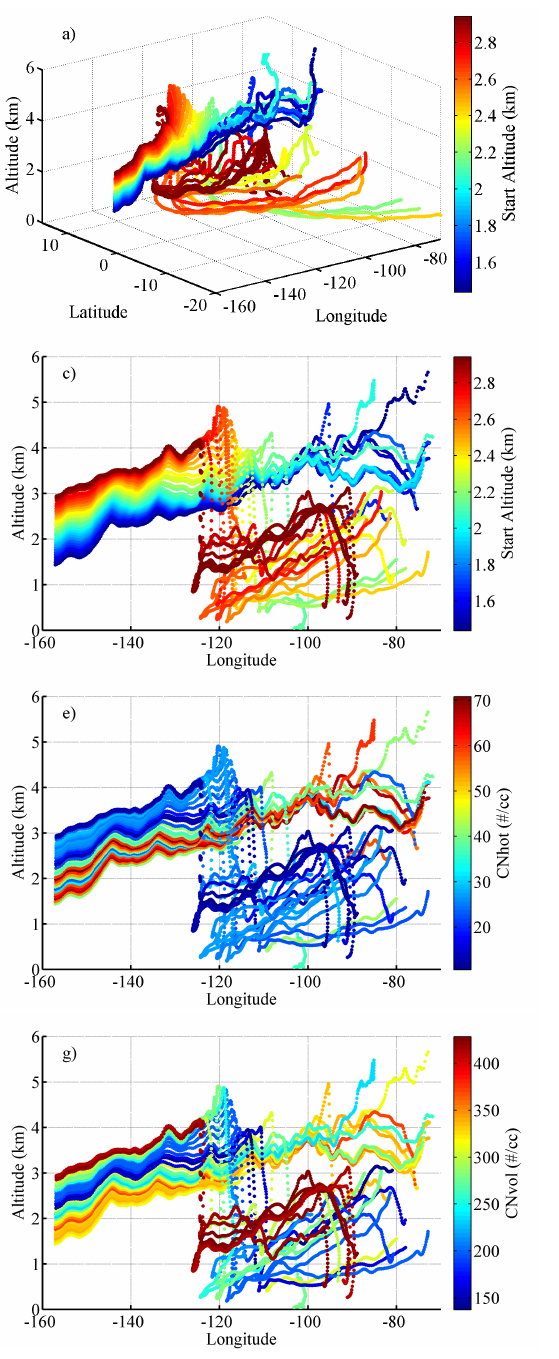
Fig. 6: Case Study I around 19:00 UTC during research flight 2 on 10 August. The 12-day back trajectories are color-coded Fig. 6. Case study I around 19:00UTC during research flight 2 on 10 August. The 12 day back trajectories are color-coded with (a – c) start with (a-c) Start Altitude, (d) total modeled precipitation along the path, (e) CNhot, (f) CO, (g) CNvol and (h) O 3 . altitude, (d) total modeled precipitation along the path, (e) CNhot, (f) CO, (g) CNvol and (h) O 3 . Ecuador and Columbia where rising motion is evident. As (Fig. 6c) from this altitude into the study region. Hence, provides another view of these trajectories over longitude accumulated over the length of 12 days for each trajectory, the modeled air parcels travel west they gradually subside measured pollution aerosol could originate from Amazon 980 and altitude. This projection provides a clear illustration while plots e–h demonstrate CNhot, CO, CNvol, and O 3 col- of vertical structure for PASE back trajectories. Hence, all orations, respectively. tracer and precipitation colorations are shown over longitude The back trajectories for the two pollution layers are col- ored blue in Fig. 6a–c and extend back to about 75 ◦ W, 5 ◦ and altitude. Plot d illustrates modeled GDAS precipitation